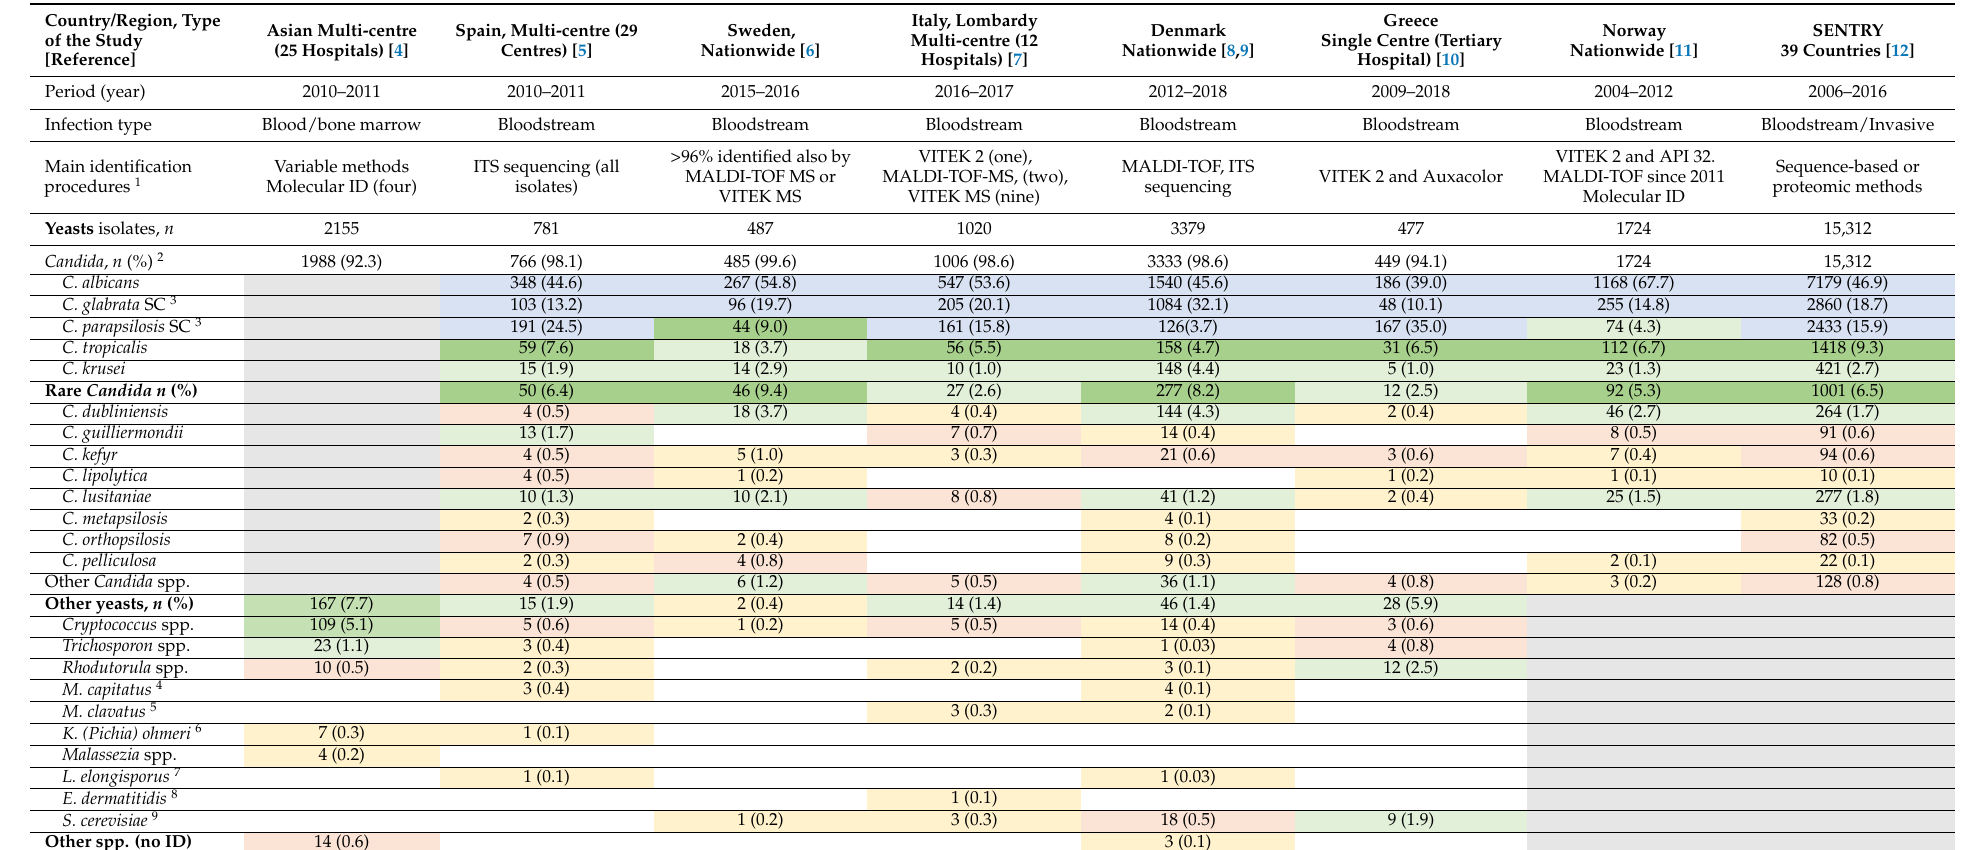
Table 1. Overview of yeast species distribution among invasive infections based on selected